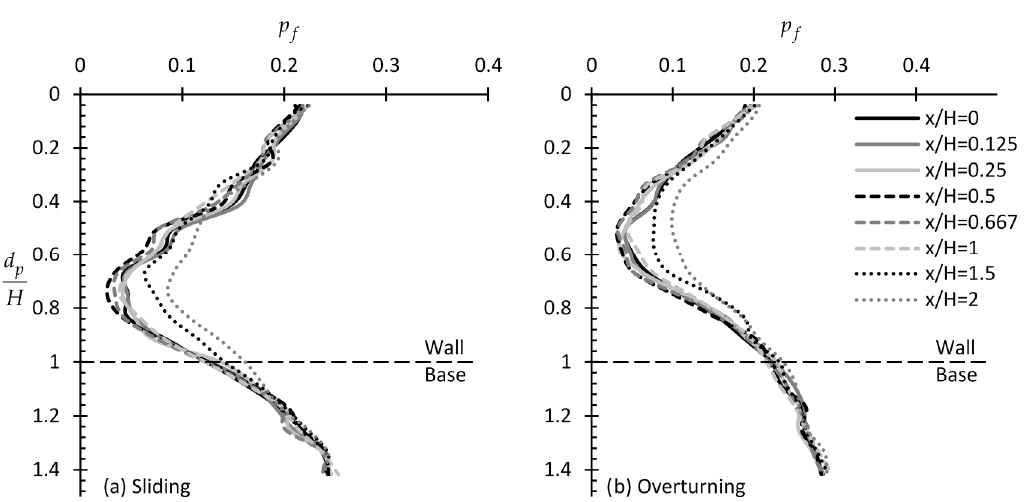
Figure 10. f p - p d H curves for various x H values for the ( a ) sliding and ( b ) overturning wall Figure 10. p f − d p / H curves for various x / H values for the ( a ) sliding and ( b ) overturning wall considering θ θ= = anisotropic soil ( θ h / H = 20.8, θ v / H = 2.08; to be compared with Figure 3c,d, considering anisotropic soil ( 20.8, 2.08 h v H H ; to be compared with Figure 3c,d, respectively).